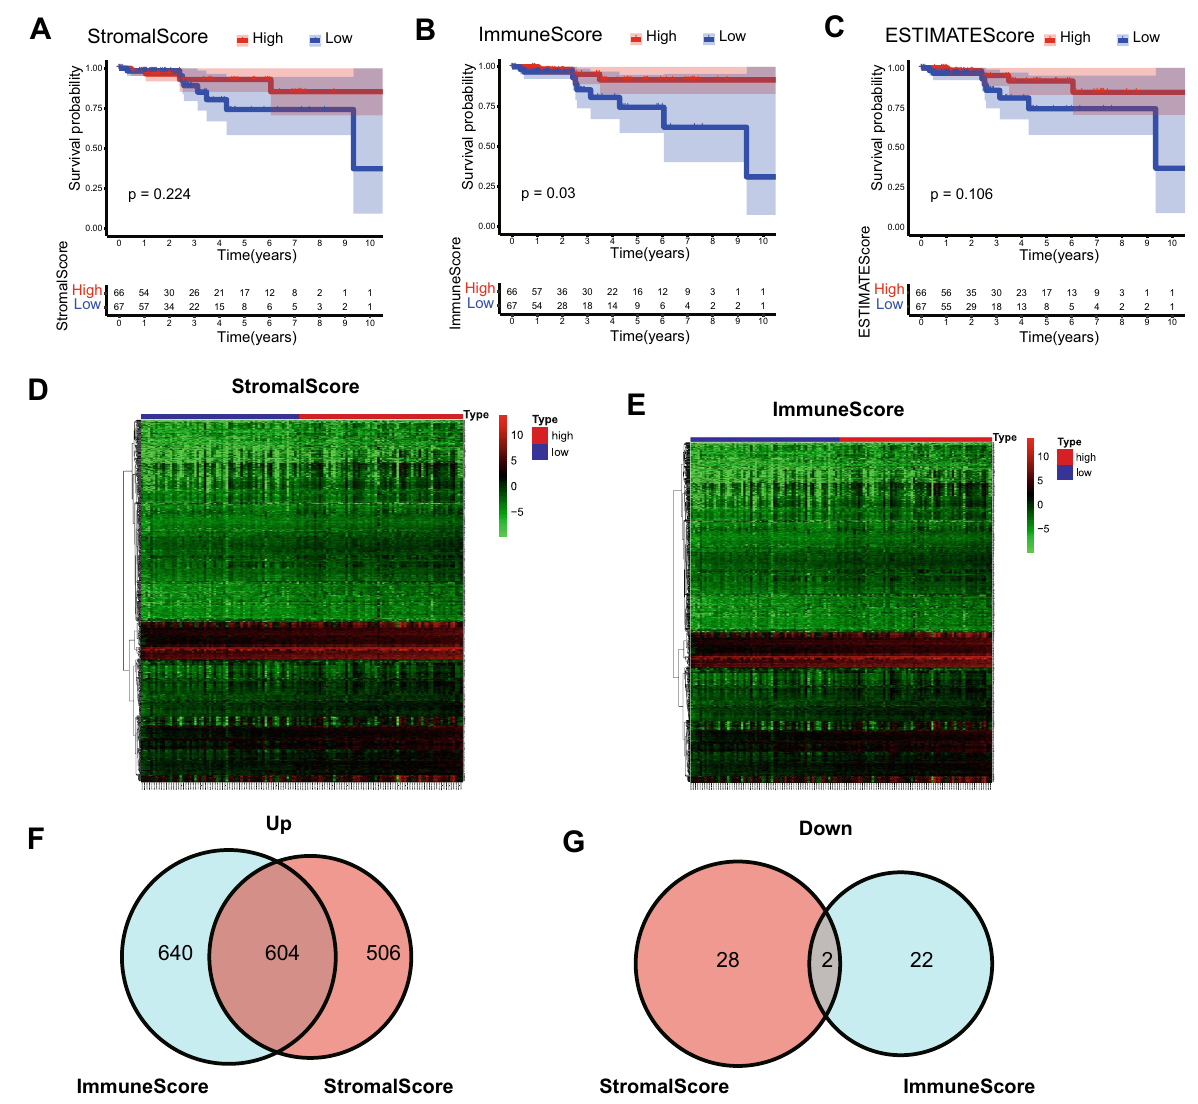
Figure 1. Survival analysis and differentially expressed genes based on the ESTIMATE algorithm in the training cohort. ( A – C ) Kaplan–Meier survival curves of patients grouped by the median of StromalScore, ImmuneScore and ESTIMATEScore. ( D , E ) Heatmap of differentially expressed genes between the high score group and the low score group from StromalScore data and ImmuneScore data. ( F ) Venn diagram of the upregulated differentially expressed genes from StromalScore data and ImmuneScore data. ( G ) Venn diagram of the downregulated differentially expressed genes from StromalScore data and ImmuneScore lation, cytolytic activity, CCR, inflammation promotion, parainflammation and APC coinhibition. Based on the ssGSEA score, the CD8 T cell/Treg ratio and CD8 T cell/neutrophil ratio were calculated. As shown in Fig. S3, the CD8 T cell/Treg ratio ( p < 0.001) and CD8 T cell/neutrophil ratio ( p < 0.001) were both higher in the low-risk group than in the high-risk group. Furthermore, unsupervised clustering analysis indicated that the patients with a low-risk score almost always harbored greater immune infiltration (Fig. 4C). In addition, the ESTIMATE analysis showed that the low-risk score group possessed a higher StromalScore ( p < 0.001), Immu- neScore ( p < 0.001) and ESTIMATEScore ( p < 0.001) than the high-risk score group in both cohorts (Fig. 4D). Identification and functional enrichment of DEGs grouped by risk scores. Next, we analyzed the DEGs between different risk score groups in both cohorts. Our results showed that 3338 DEGs were identified in the training cohort ( p < 0.05, Fig. 5A), and 1205 DEGs were identified in the validation cohort ( p < 0.05, Fig. 5B). Among these genes, 322 overlapping DEGs were found with the cutoff p < 0.01 (Fig. S2). Furthermore, the potential functions of 322 DEGs were evaluated according to Kyoto Encyclopedia of Genes and Genomes (KEGG) and gene ontology (GO) enrichment analyses. KEGG analysis showed that immune- related pathways (including cytokine–cytokine receptor interaction pathway, antigen processing and presenta- tion, B cell receptor signaling pathway and chemokine signaling pathway) are potentially the most important